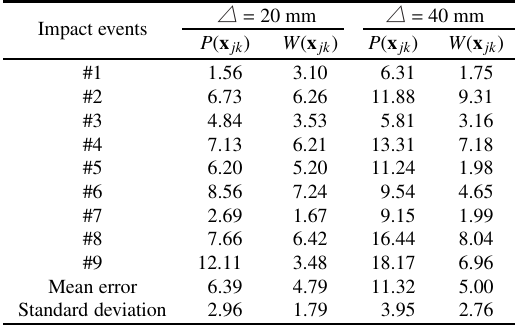
Table 1 Mean error and standard deviation in impact location detection